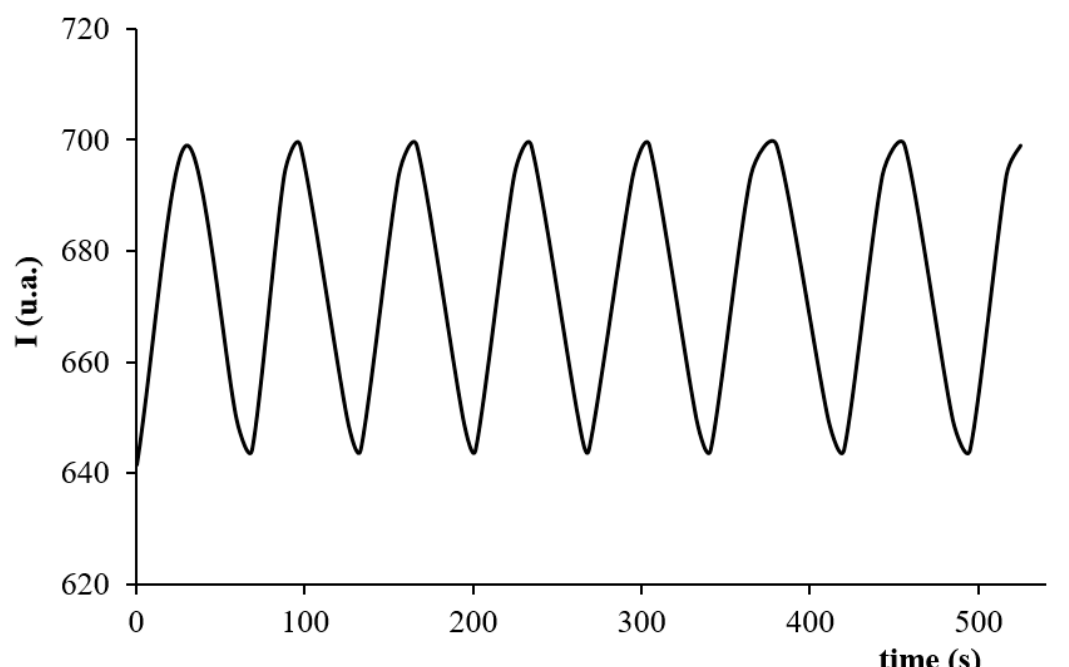
Figure 4. Response and recovery time of CO 2 sensing membrane while increasing and decreasing CO 2 concentrations (from 10% to 90% and vice-versa).